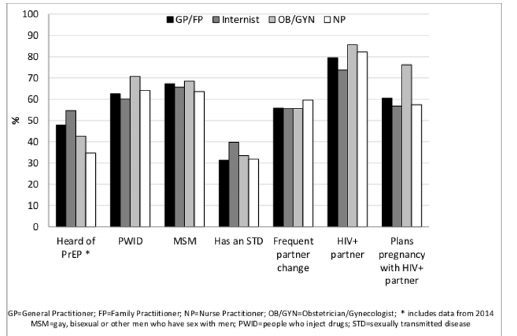
Fig 2. Awareness of PrEP and Willingness to Prescribe PrEP to Persons with Selected Risks for HIV Acquisition by Provider Type, DocStyles, 2009 – 2015, United States.